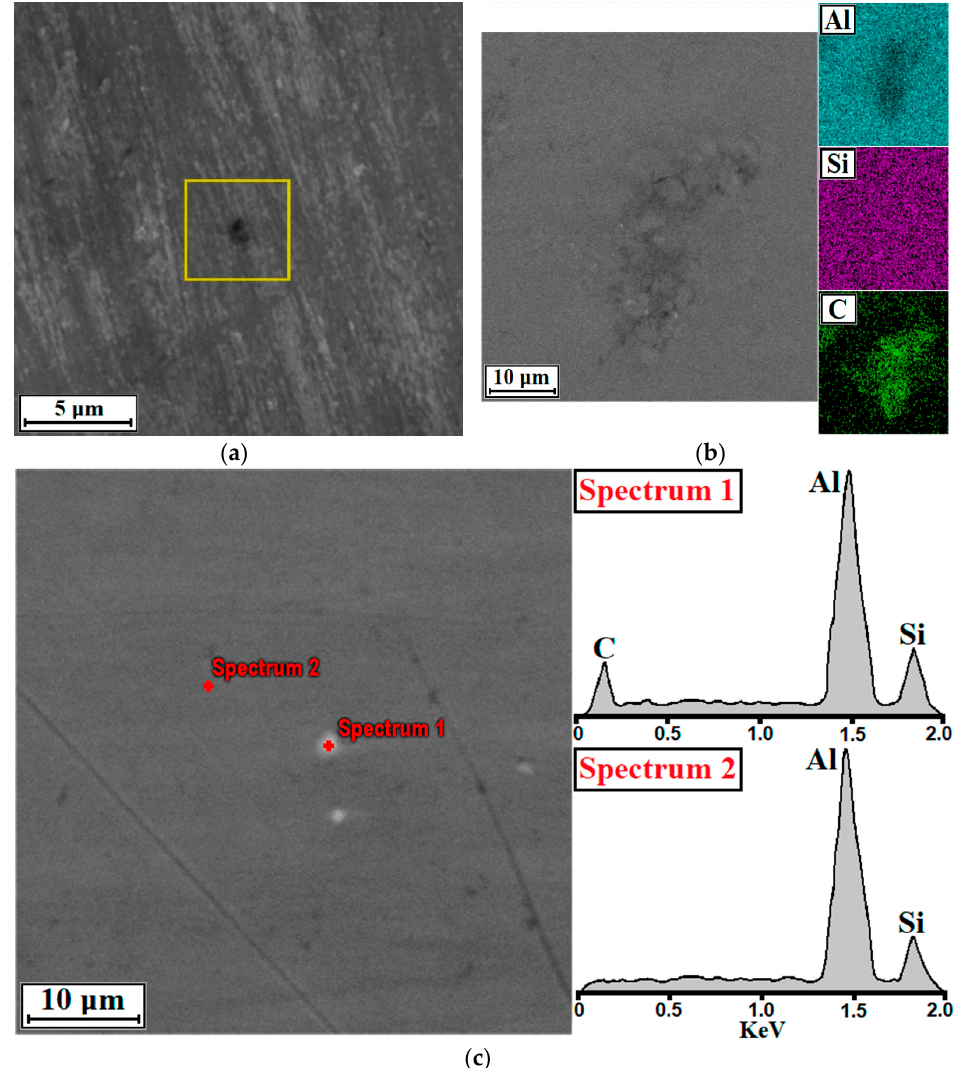
Figure 9. Characterization of the printed Al–C samples: ( a ) SEM image; ( b ) chemical distribution map; ( c ) EDX analysis .